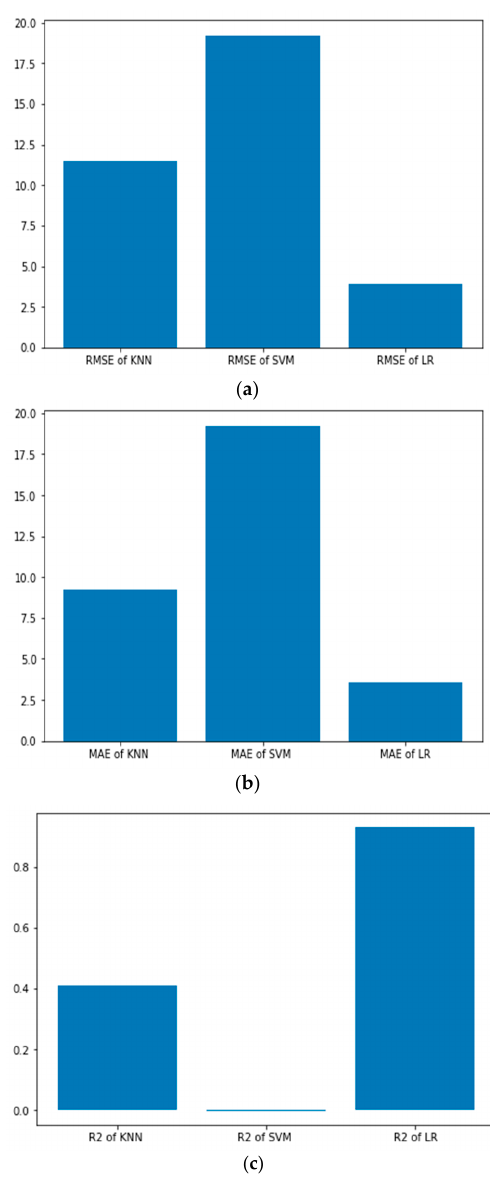
Figure 7. Performance comparison of three different models ( a ) RMSE ( b ) MAE ( c ) R 2 values. The R 2 values obtained for KNN, SVM and Linear Regression models are 0.41, − 0.02, and 0.93, respectively. Since the amplitude of the reflected signals decreases as the soil moisture increases, there is a linear relationship between the reflected signals and the soil moisture. KNN and SVM are the classification algorithms, so they work better if the num- ber of target values is lesser (two or three) [30]. Here, the target range is VWC, whose value ranges from 3% to 40%. So, a regression algorithm (Linear regression in this case) works better [30]. Also, a neural network model was trained in the NN toolbox of MATLAB. The neural network type is Feed Forward Backprop and the training function is TRAINLM. The model is a two-layered network (Shallow Neural network) with 10 neu- rons in the first layer and with LEARNGDM as the adaption learning function and the performance function based on MSE. The measured vs. predicted values by the neural network model is shown using a regression plot in Figure 8. The R square value for neural network prediction is 0.9894 and it performs better than the other trained models. The per- formance metrics RMSE, MAE and R 2 are chosen since the final output is a number and they are used for regression algorithms. These metrics were also used to compare the machine learning algorithms in [16] for soil moisture estimation but the accuracy alone was used in [17] to compare the algorithms for soil moisture prediction. The limitation of this study is that only one soil type is used, which is readily available and prevalent; however, later, this research will be extended to other conditions and soil types found in Singapore. Figure 8. Neural network model. Measured vs. Predicted Values.